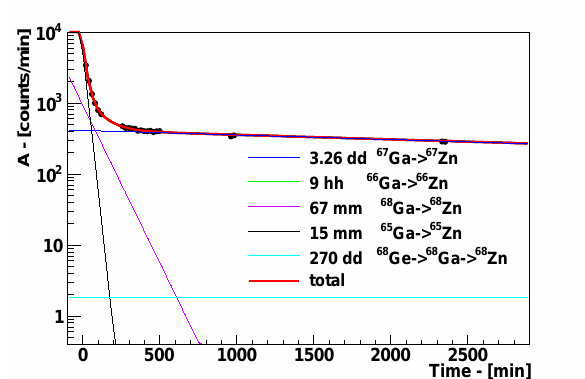
Fig. 2. Activity curve for the Ga isotopes.